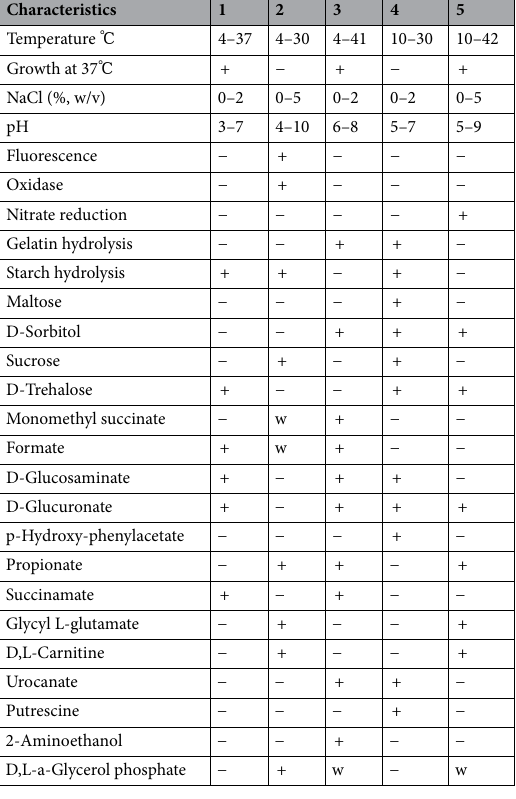
Table 3. Phenotypic characteristics distinguishing Pseudomonas eucalypticola sp. nov. from phylogenetically related Pseudomonas type strains. 1, Pseudomonas eucalypticola NP-1 T ; 2, P. coleopterorum LMG28558 T ; 3, P. weak